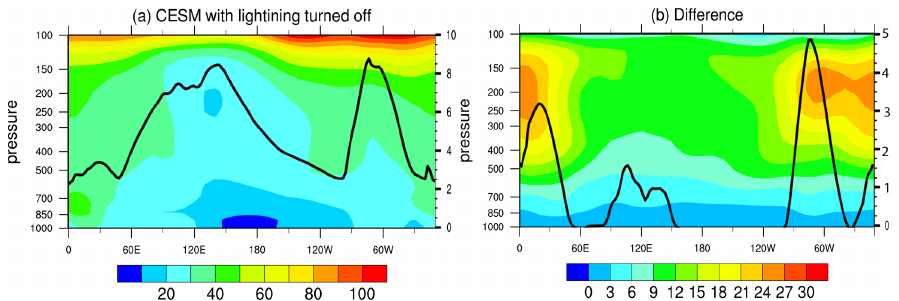
Figure 3. Tropospheric ozone climatology for boreal winter (November–April) averaged between 10 ◦ S and 10 ◦ N for (a) a run with CAM- chem lightning turned off (color, in ppb) with precipitation (line, in mmday − 1 ) and (b) the difference between the control run and the run with lightning turned off (color, in ppb) with the lightning NO x source (line, in 1e − 3 TgNyr − 1 ).